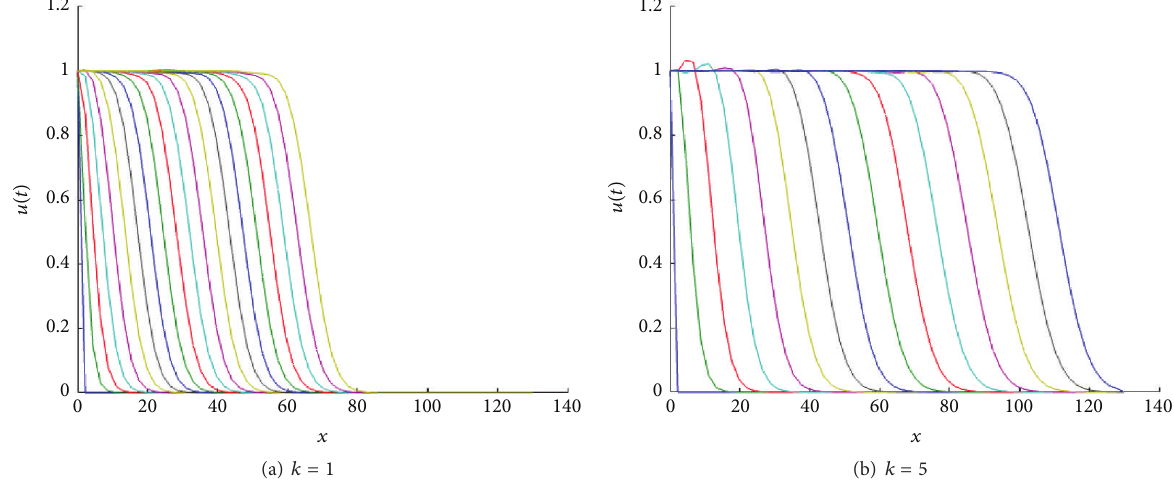
Figure 1: Front traveling waves solutions of (6) at equal time intervals 𝑡 = 1,2,3,... with 𝑔(𝑢) = 𝑢(1 − 𝑢) and 𝐷(𝑢) = 𝑢(1.0 + 𝛽𝑢) for 𝛽 = 1 . The values for 𝑘 are indicated in each figure. The initial condition used was 𝑢(𝑥,0) = 0.5(1.0 + tanh ((0.4 − 𝑥)/0.1)) , over the spatial domain is 0 < 𝑥 < 140 .